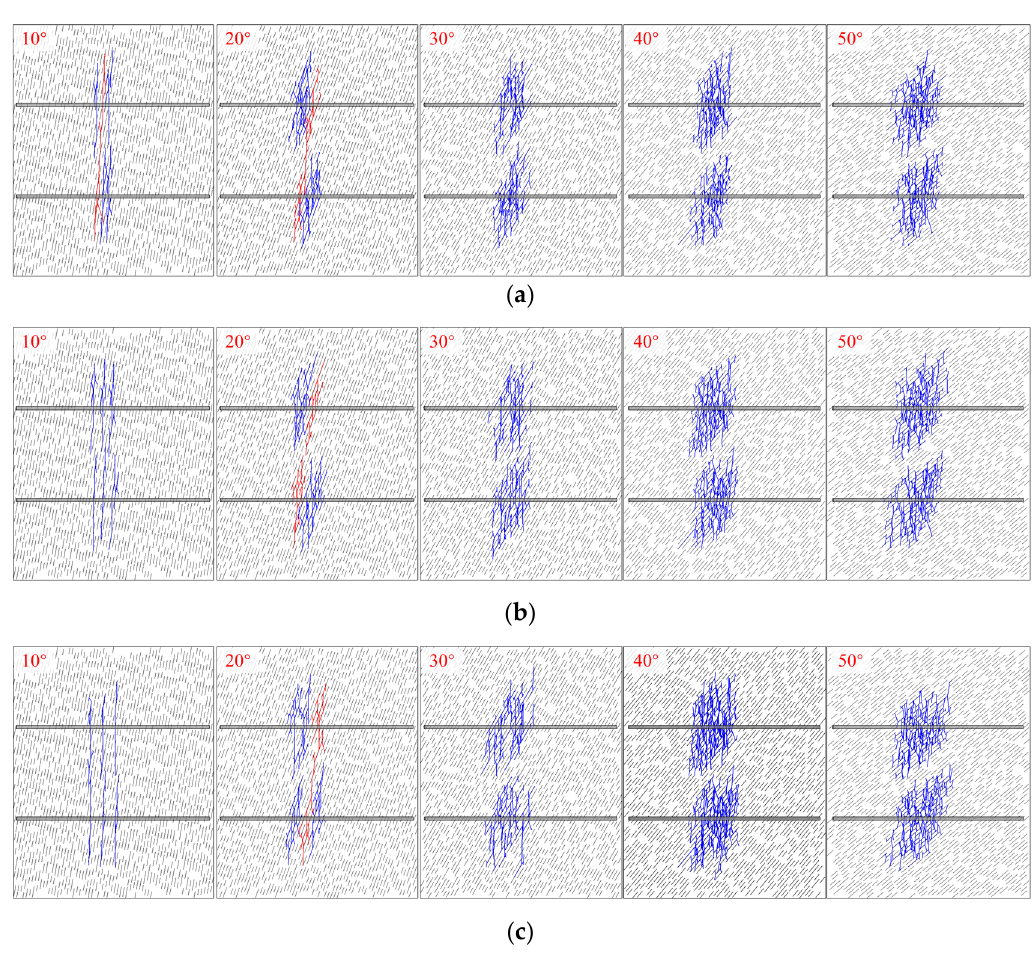
Figure 16. HF geometries for different NF orientations at varied fracture spacings: ( a ) 20 m; ( b ) 30 m; ( c ) 40 m.